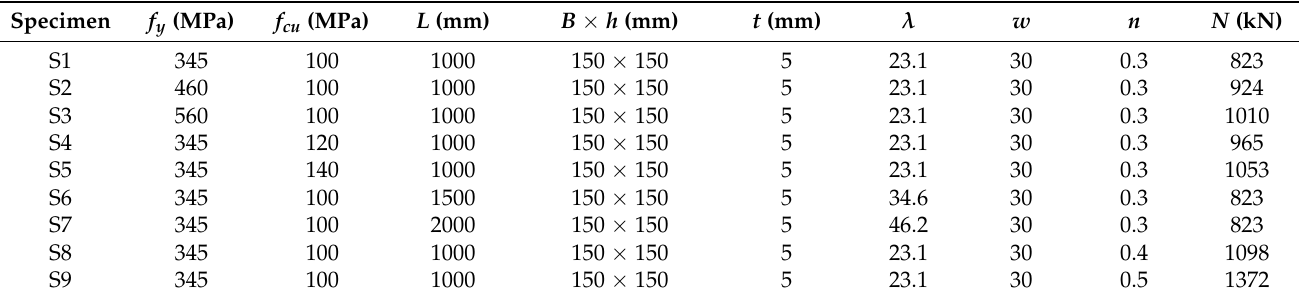
( c ) The effect of length-diameter ratio Figure 13. Cont